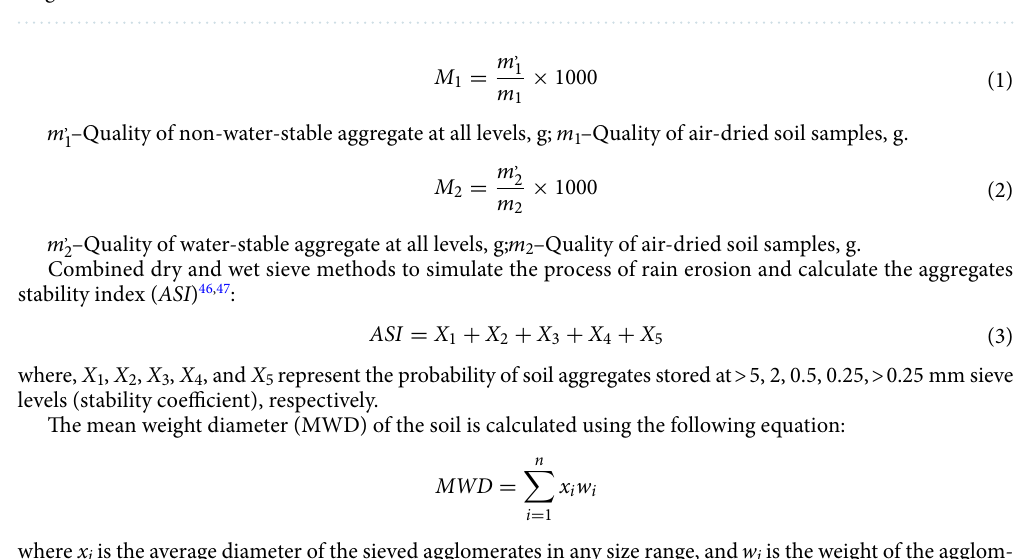
Figure 5. Cohesion and internal friction angle of the soil under different NAA content. ( a ) Cohesion, and ( b ) Angle of internal